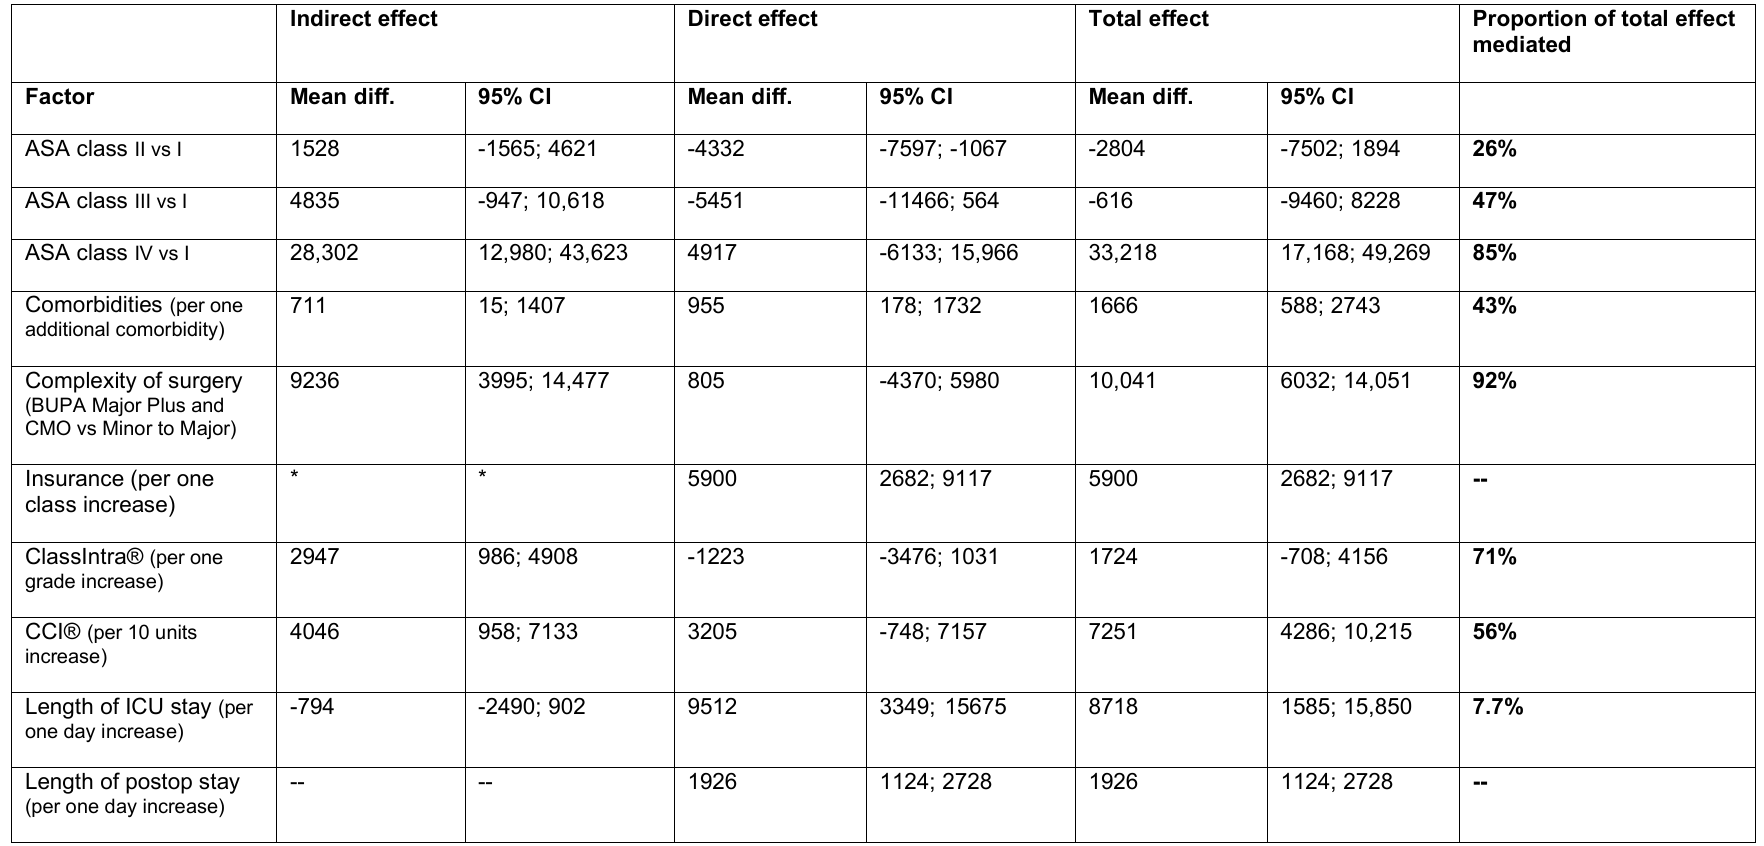
Table 8: Cost model excluding recurrent patients and patients with a protracted hospital or ICU stay (in Euros) Indirect, direct and total effects on costs. Coefficients are mean differences in cost; patients with protracted hospital or ICU stay were excluded in order to meet the linearity assumption. R-squared 60.4%